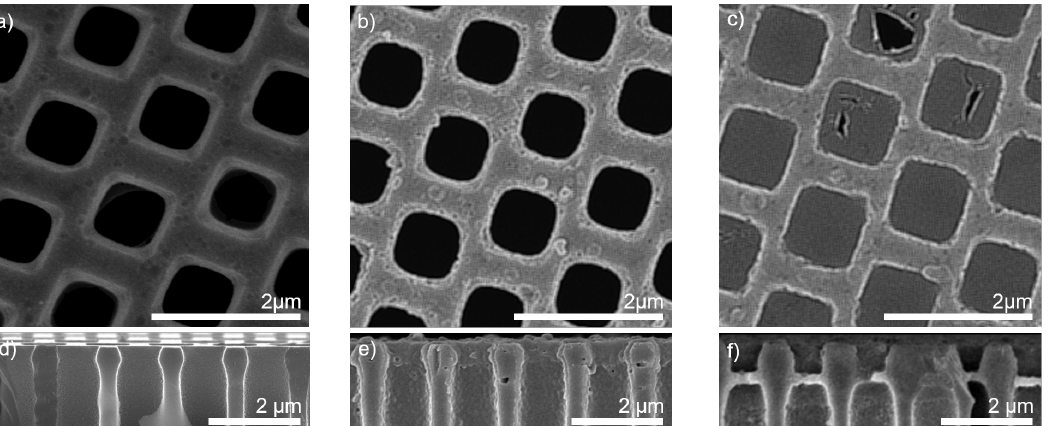
Figure 2. FESEM imaging of isoporous silicon support structures. ( a ) top view and ( d ) cross sectional view of silicon support structure withouth coating; ( b ) top view and ( e ) cross sectional view of three bilayers PDADMAC/PSS on isoporous silicon support with fully water-wetted suppport during polyelectrolyte complexation; ( c ) top view and ( f ) cross sectional view of three bilayers PDADMAC/PSS on silicon support with air-filled support during polyelectrolyte complexation.